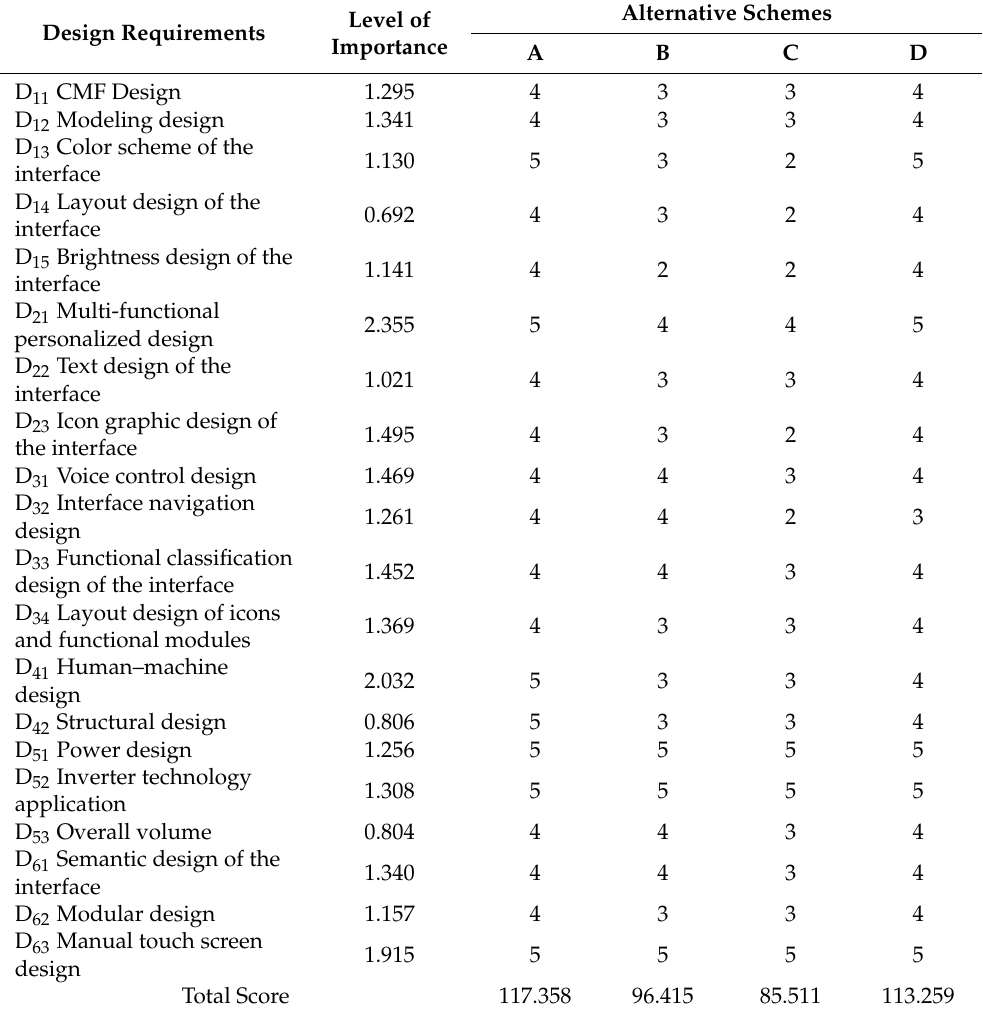
Table 5. Correlation between user needs and evaluation